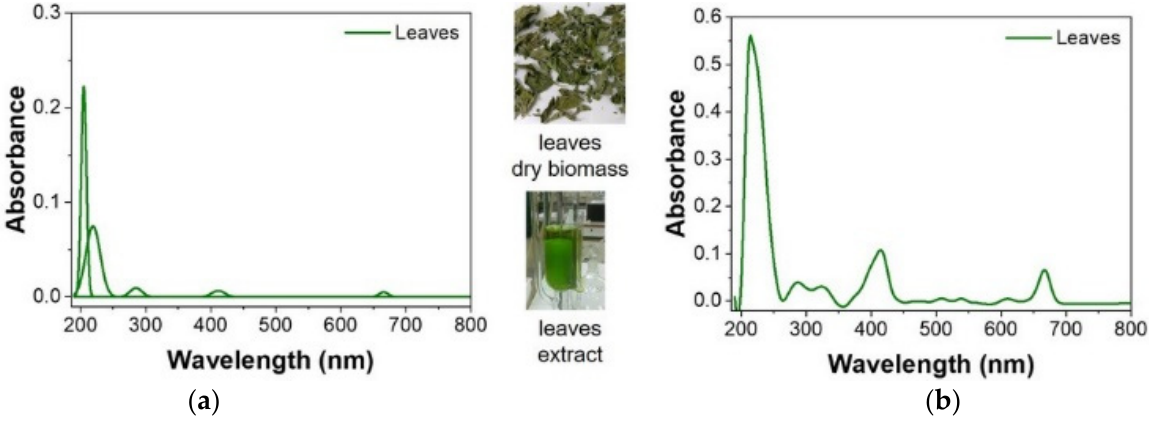
Figure 6. UV–VIS profile absorption spectra after deconvolution for Datura innoxia leaves matrix in ethanol extract ( a ) and 1-butanol extract ( b ).